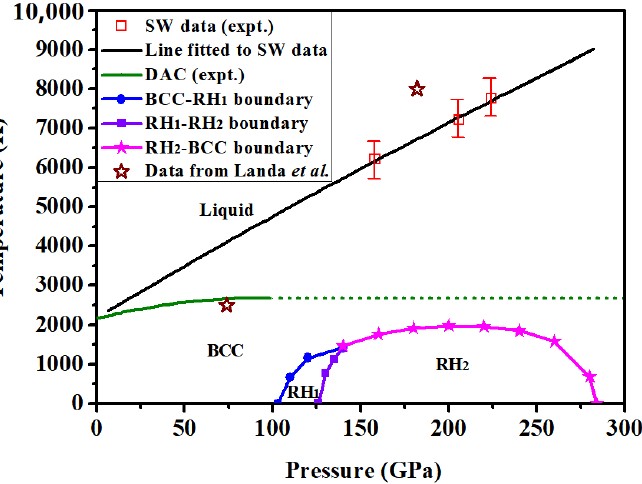
Figure 5. High-pressure and high-temperature phase diagram of vanadium. (By the courtesy of Ref. [54]). Ref.